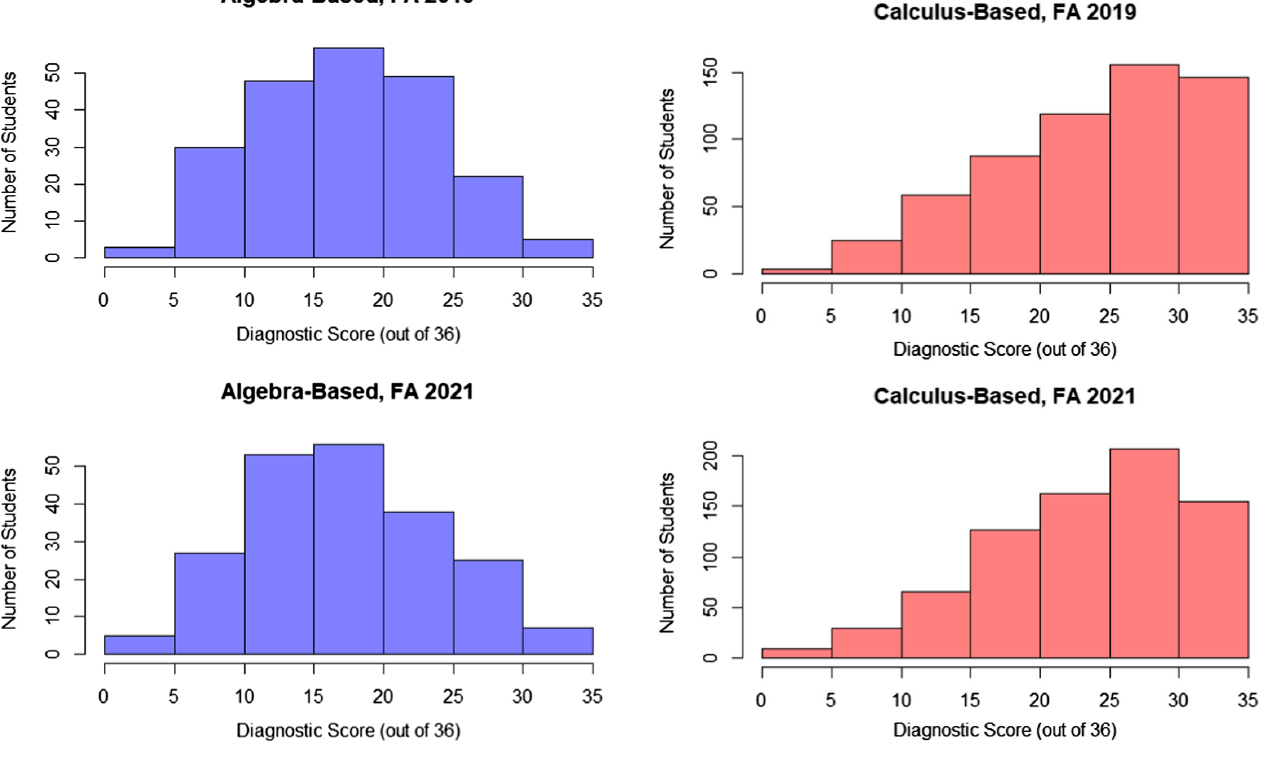
FIG. 1. Score distribution in 2019 (top) and 2021 (bottom) for students intending to enroll in algebra-based physics.